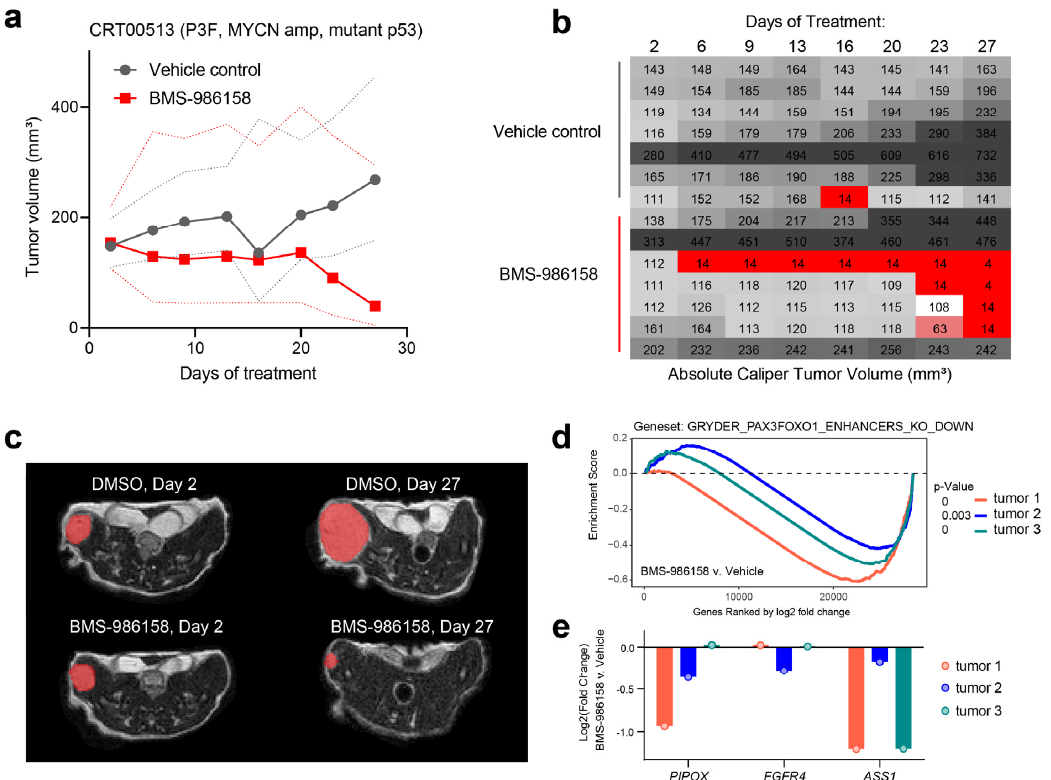
Figure 3. Effect of potent BRD4 inhibitor on FP-RMS O-PDX tumor growth in vivo. ( a ) Mice were implanted with FP-RMS PDX CRT00513 intramuscularly in the thigh and, after tumors reached a threshold volume, were dosed with vehicle or BMS-986158 once daily for 28 days. Average FP-RMS O-PDX tumor volume, measured by digital calipers via MRI, over time with vehicle or BMS-986158 treatment (average = solid line, 95% con fi dence interval = dashed line). ( b ) Tumor volumes for indi-vidual mice within each condition at each time point. ( c ) Demonstrative axial section of T2-weighted MRIs at days 2 and 27 of DMSO or BMS-986158-treated mice. Tumors highlighted in red. ( d ) Gene set enrichment analysis (GSEA) of RNA-seq from CRT00513 tumors treated with BMS-986158 for 3 days in vivo shows strong downregulation of PAX3-FOXO1 target genes. ( e ) Variability in gene expression responses for PAX3-FOXO1 target genes PIPOX , FGFR4 and ASS1 across the BMS-986158-treated tumors.